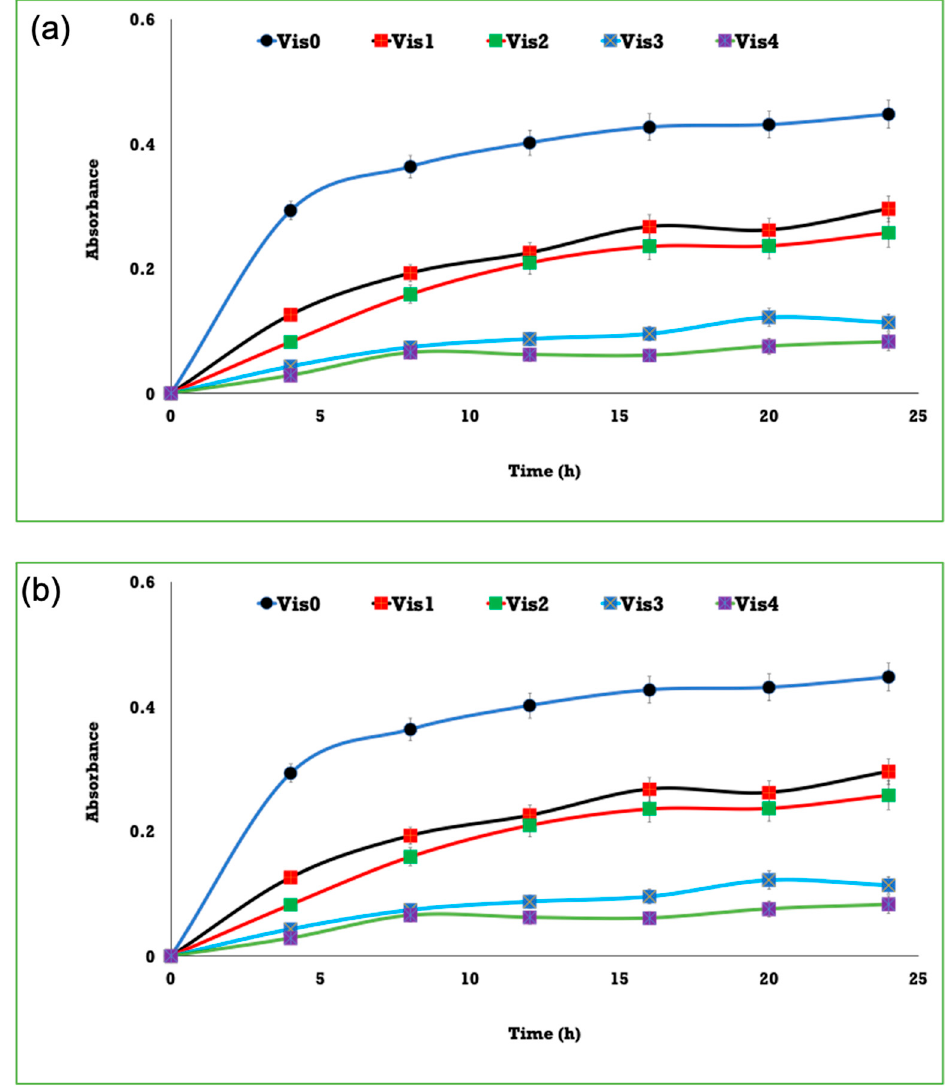
Figure 7. Activity of coated viscose fibers against E. coli ; Vis 0 is pristine viscose, Vis 1 is 10 3 (a) or 10 6 (b) bacterial density, Vis 2 is NPs/fibers, Vis 3 is nanocomposite/fibers following washing, and Vis 4 is nanocomposite/fibers prior to washing.